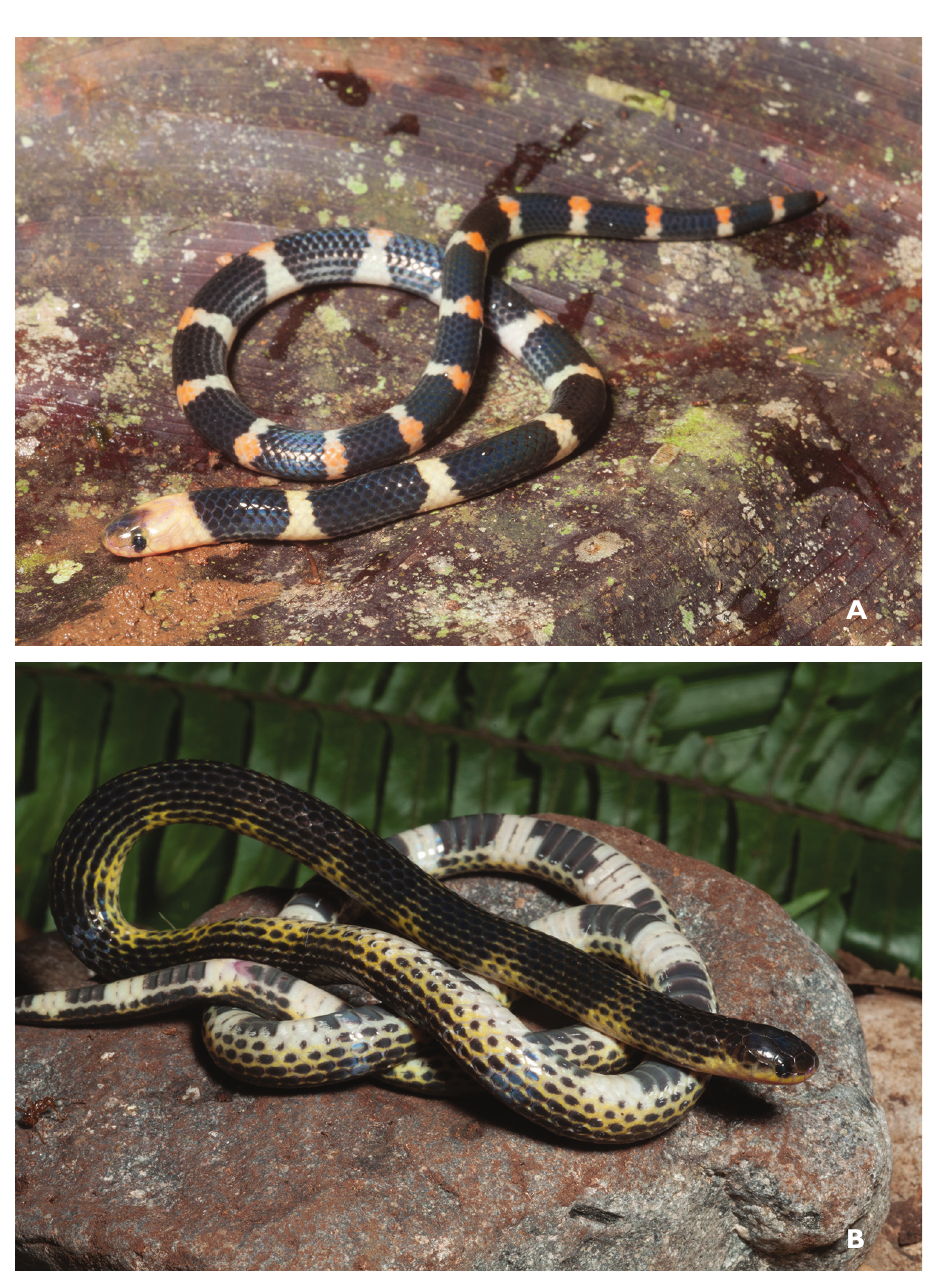
Figure 65. Ontogenetic color and pattern variation in juvenile ( A KU 334478) versus adult ( B KU 334476) specimens of Calamaria lumbricoidea from May-Impit, Mt. Hilong-hilong, Municipality of Re- medios T. Romualdez, Agusan del Norte Province. Photos: RMB.